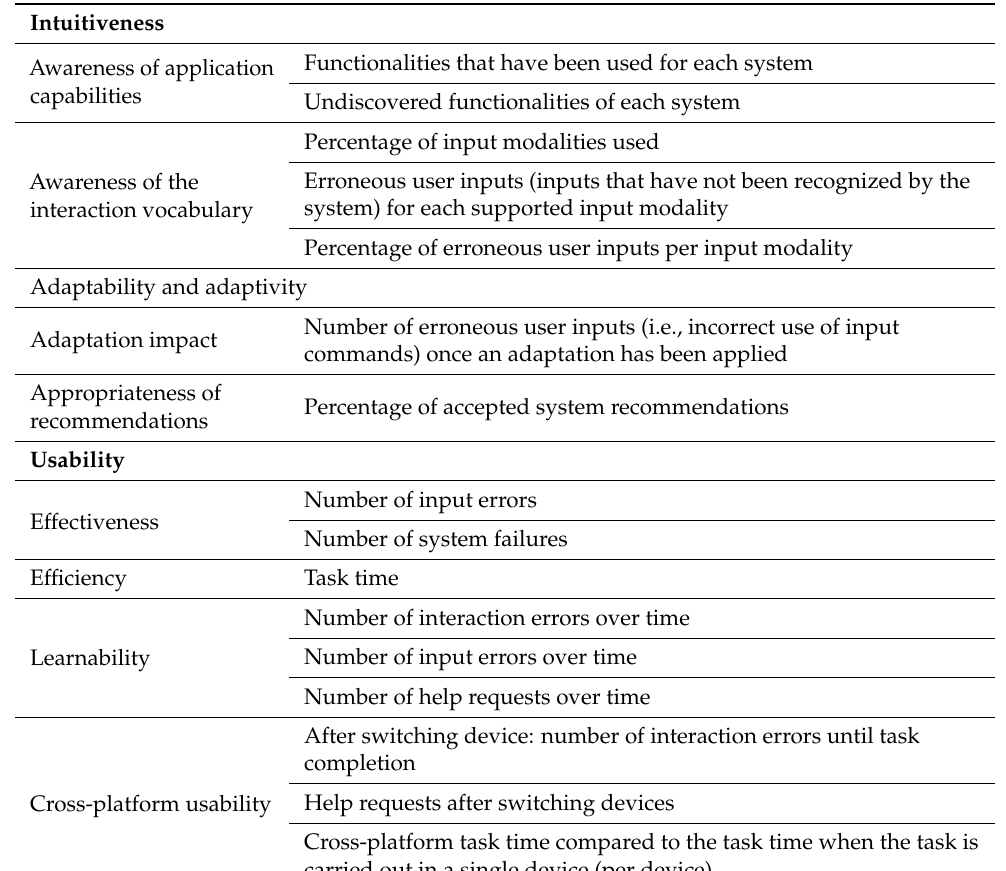
Table A3. UXIE metrics automatically measured during a user-based